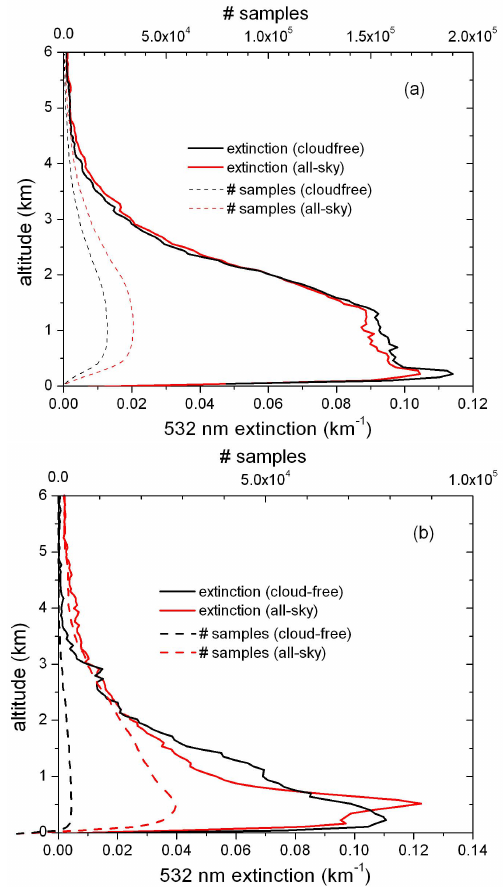
Fig. 8. Mean nighttime profiles. (a) Over eastern US (31–41 ◦ N, 95–75 ◦ W) during July 2006–2011; (b) over SE Asia (1–19 ◦ N, 90– 110 ◦ E) during August 2006–2011. Solid lines: 532nm aerosol ex- tinction; dashed lines: number of aerosol